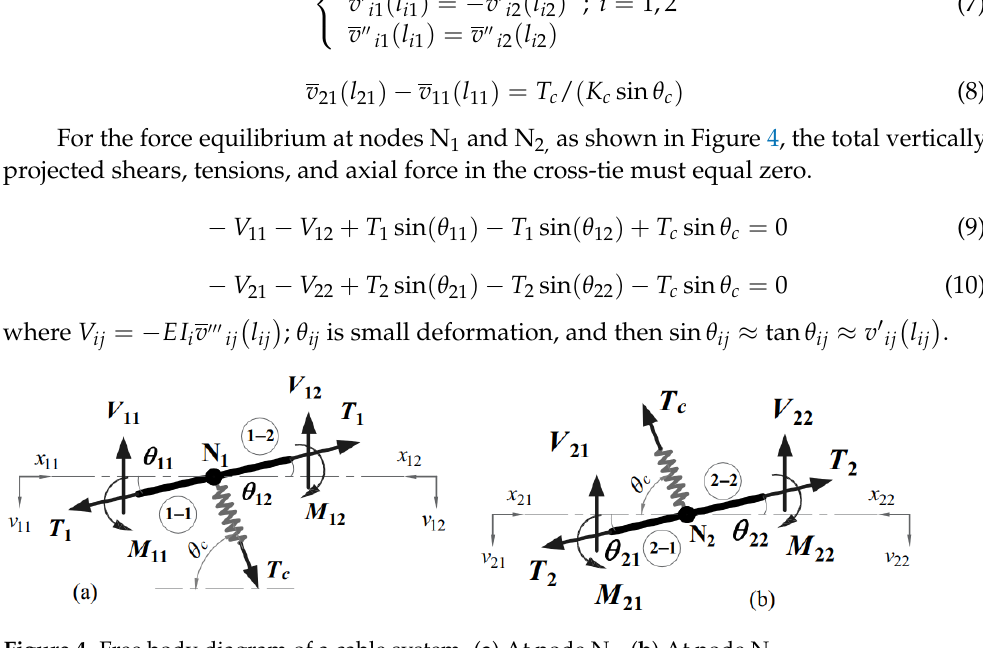
Figure 4. Free body diagram of a cable system. ( a ) At node N 1 , ( b ) At node N 2 . In Figure 4, symbols T i , V ij , M ij, , and θ ij are the tensions, shears, moments, and slopes of the four segments at location l ij , respectively.